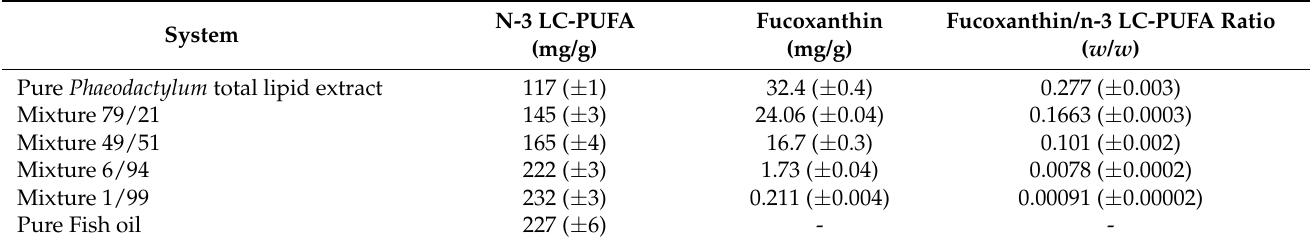
Table 3. Characterization of the different Phaeodactylum total lipid extract–fish oil mixtures in terms of n-3 LC-PUFA and